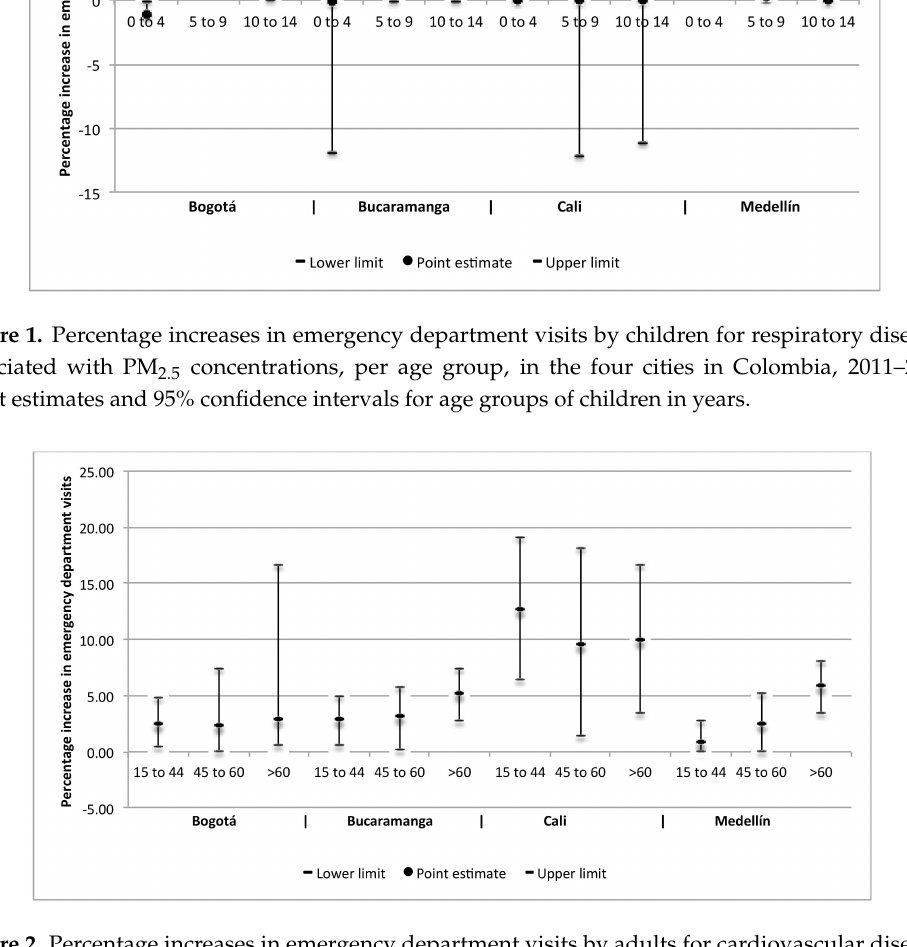
Figure 2. Percentage increases in emergency department visits by adults for cardiovascular diseases associated with concentrations in NO 2 , per age group, in four cities in Colombia, 2011–2014. Point estimates and 95% confidence intervals for age groups of adults in